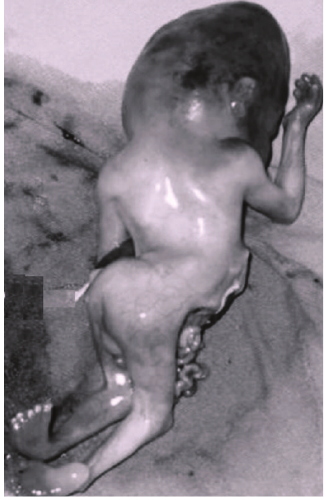
Figure 9: Limb body wall complex.